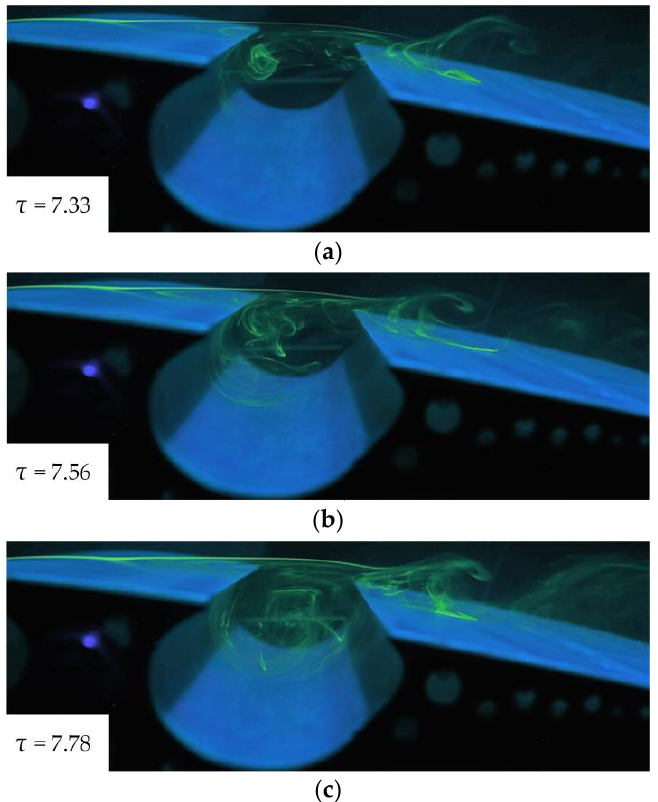
Figure 20. Flow images for cavity B at Re = 2 × 10 4 , α = 9 ◦ : ( a ) τ = 7.33; ( b ) τ = 7.56; ( c ) τ =